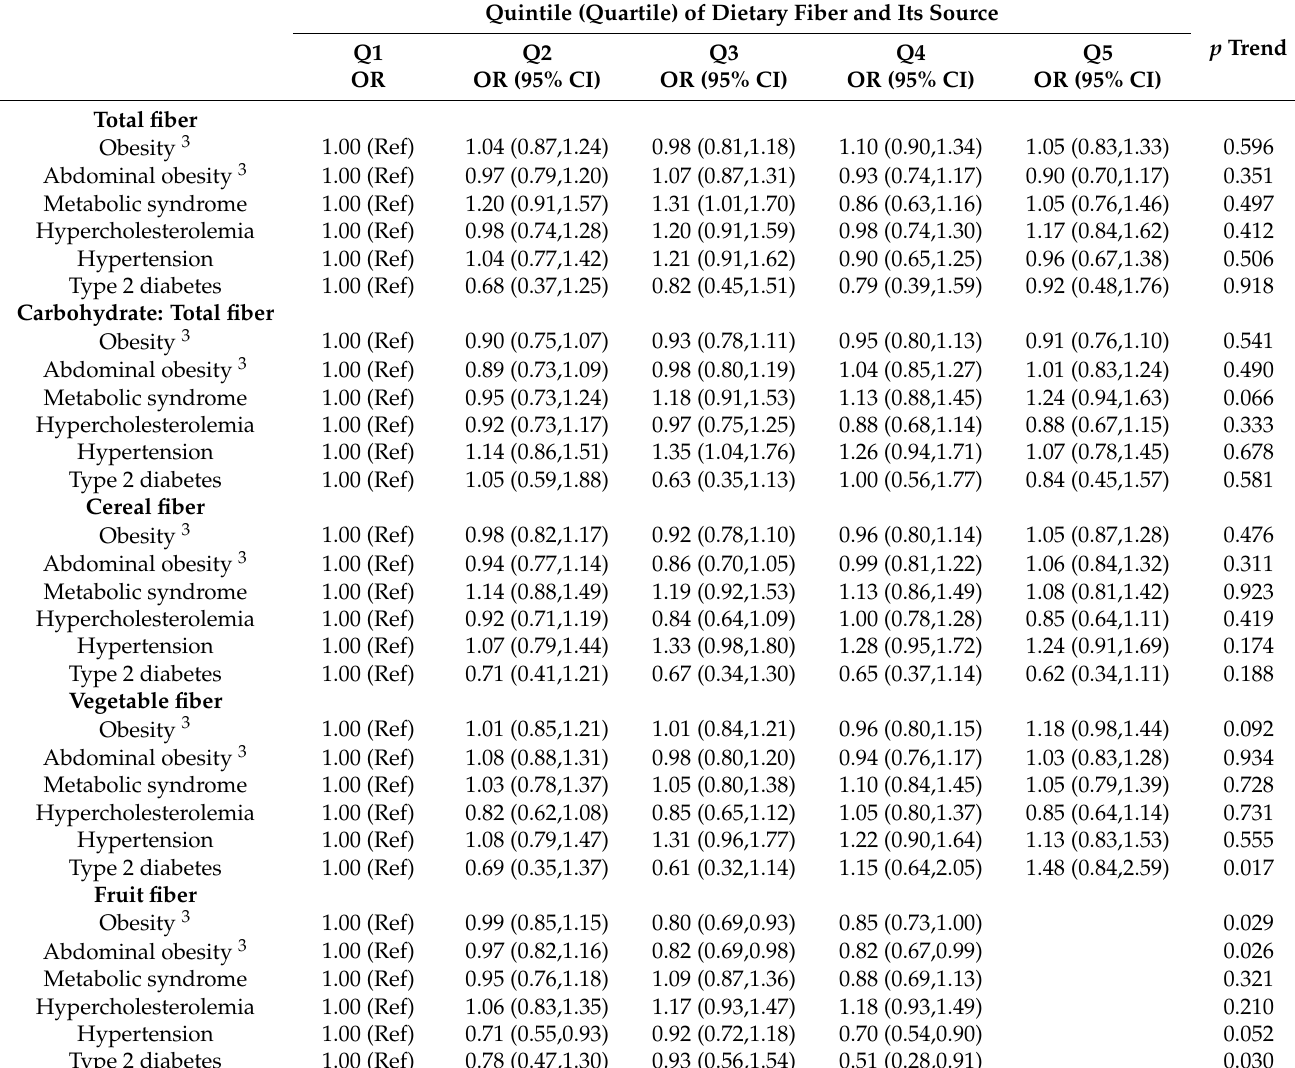
Table 4. Associations of dietary fiber and its source with cardiovascular risk factors among Korean women 1,2 . Quintile (Quartile) of Dietary Fiber and Its